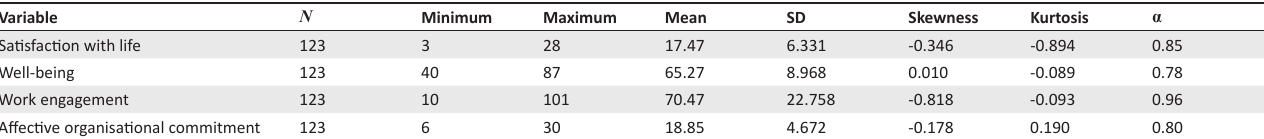
TABLE 2: Descriptive statistics.